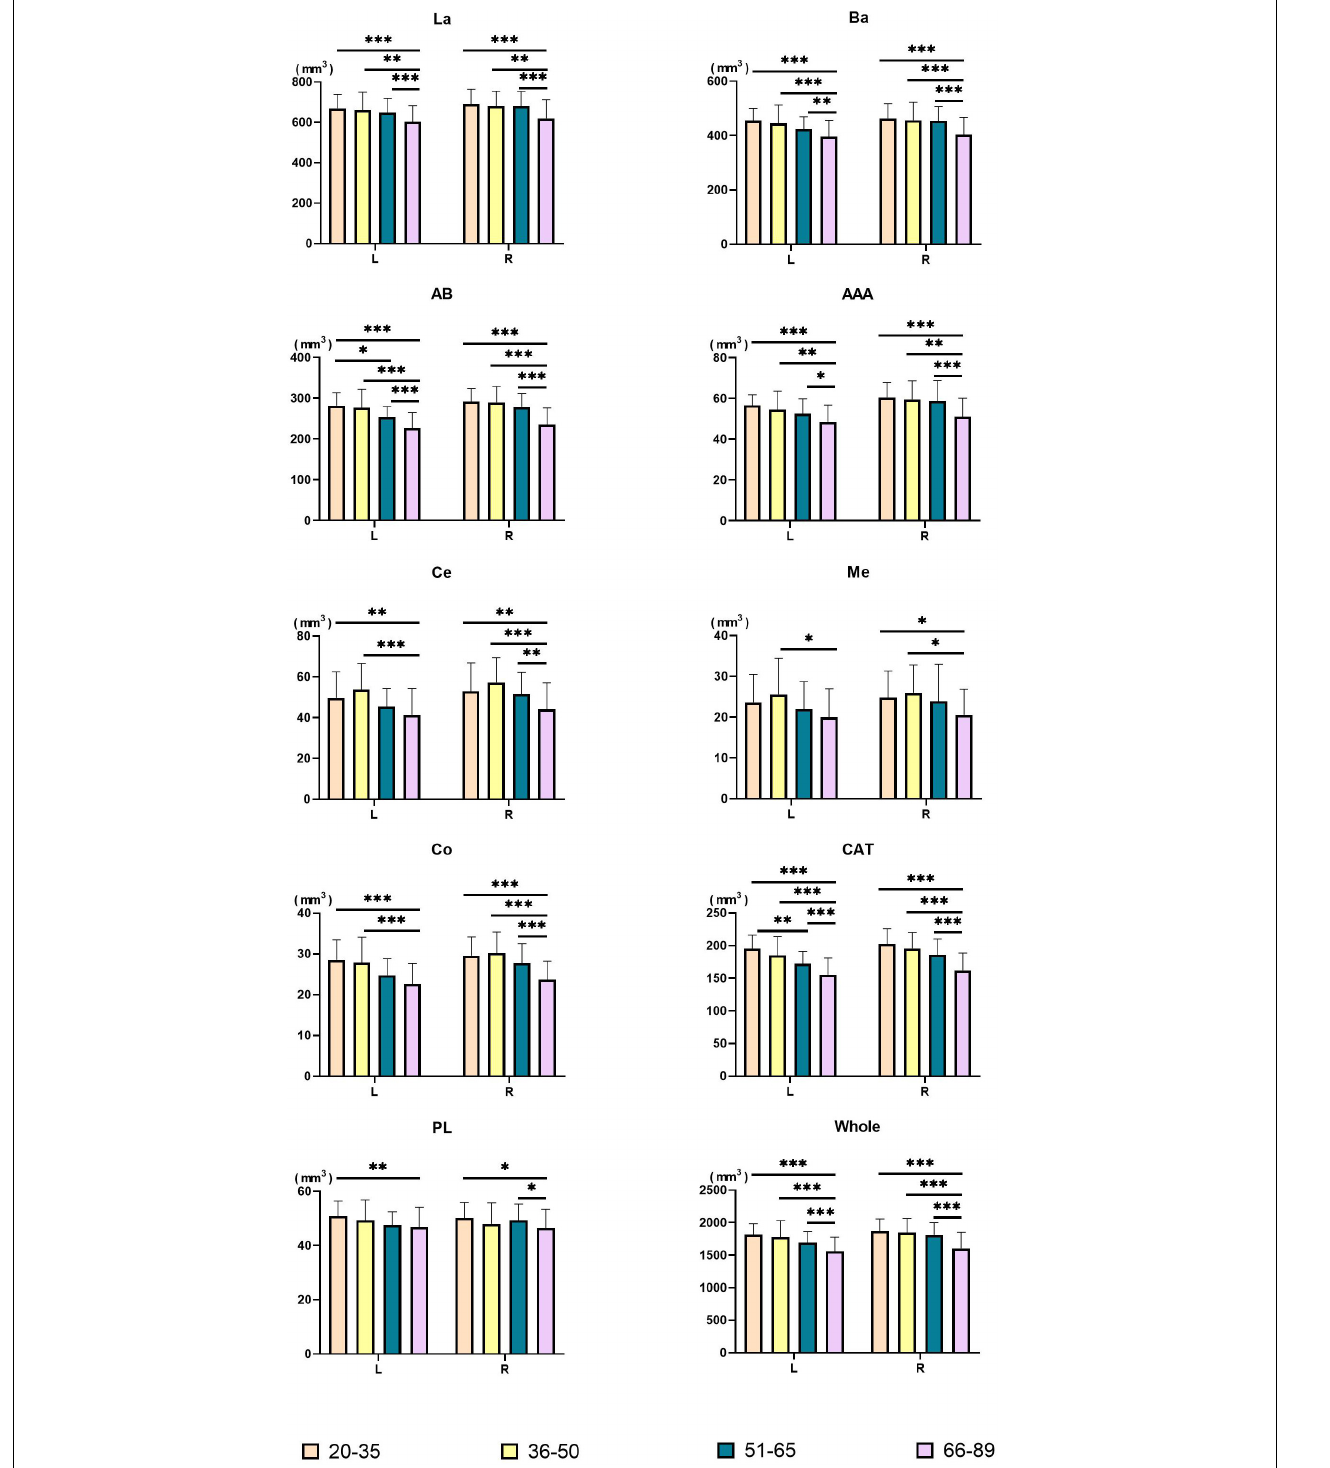
FIGURE 3 | Pairwise comparisons of amygdala nuclei volumes between age groups. X -axis, age groups; Y -axis, amygdala nuclei volumes. The left and right amygdala were presented in groups. ∗ P < 0.05, ∗∗ P < 0.01, ∗∗∗ P < 0.001. L, left hemisphere; R, right hemisphere; La, lateral nucleus; Ba, basal nucleus; AB, accessory basal nucleus; Ce, central nucleus; Me, medial nucleus; Co, cortical nucleus; AAA, anterior amygdaloid area; CAT, cortico-amygdaloid transition area; PL, paralaminar nucleus; Whole, whole amygdala.